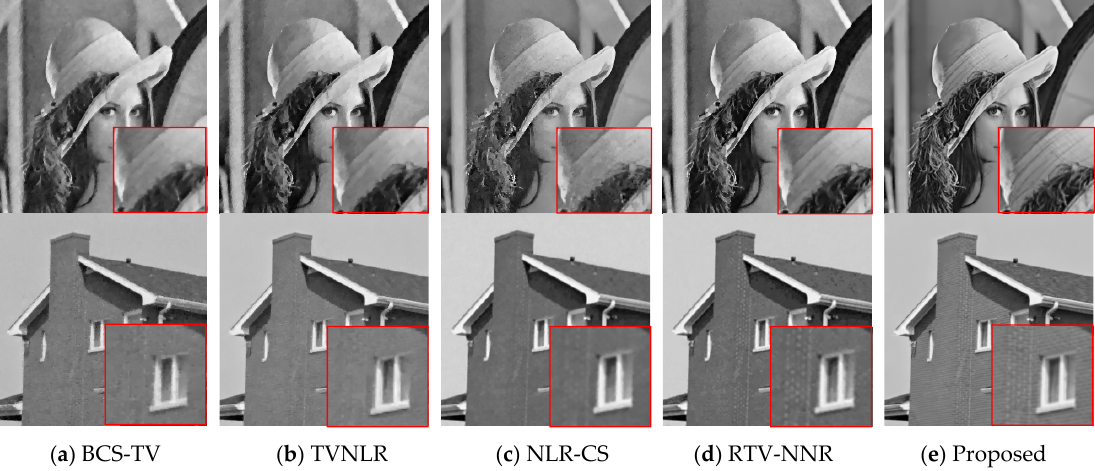
Figure 6. Reconstructed images by five methods for a sampling ratio of 5%.